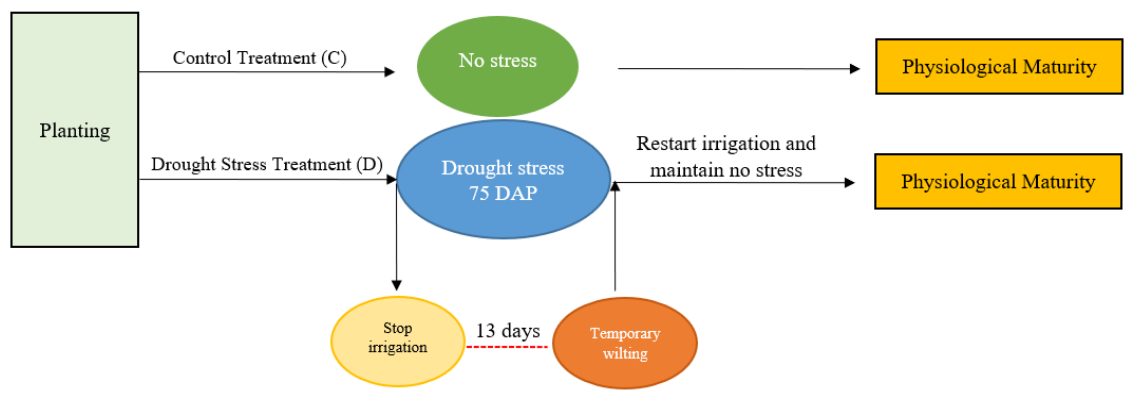
Figure 1. Scheme of irrigation water application in control (C) and drought stress (D) treatments.